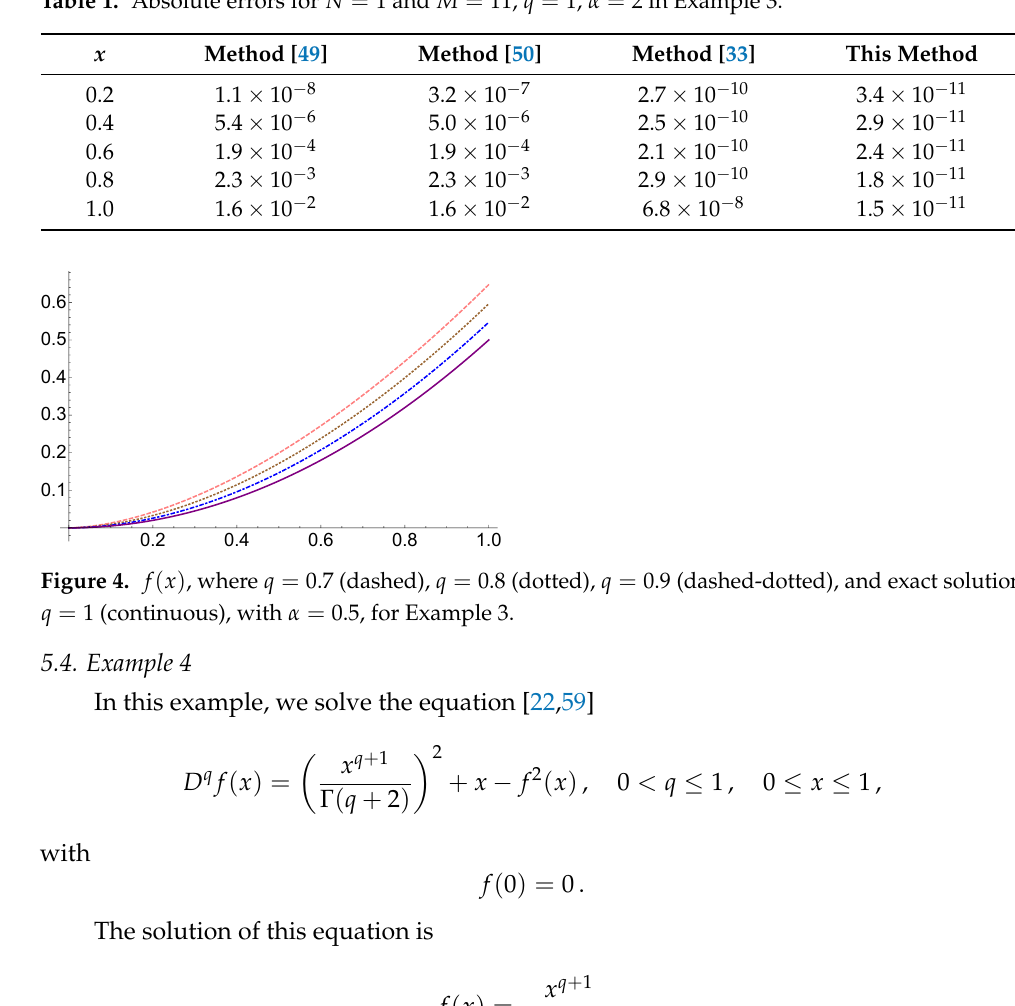
Table 1. Absolute errors for N = 1 and M = 11, q = 1, α = 2 in Example 3.